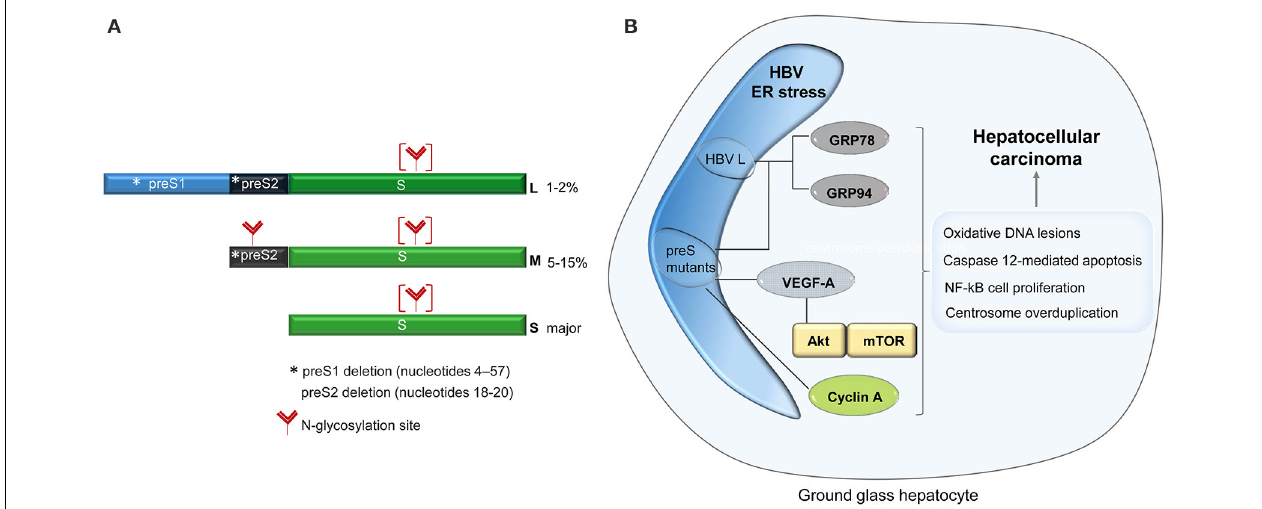
FIGURE 1 | Schematic representation of the HBV surface proteins. The asterisk shows the location of the major mutations identified in patients with ground glass hepatocytes (A) . Signaling pathways activated in ground glass hepatocytes, with potential role in carcinogenesis (B) .